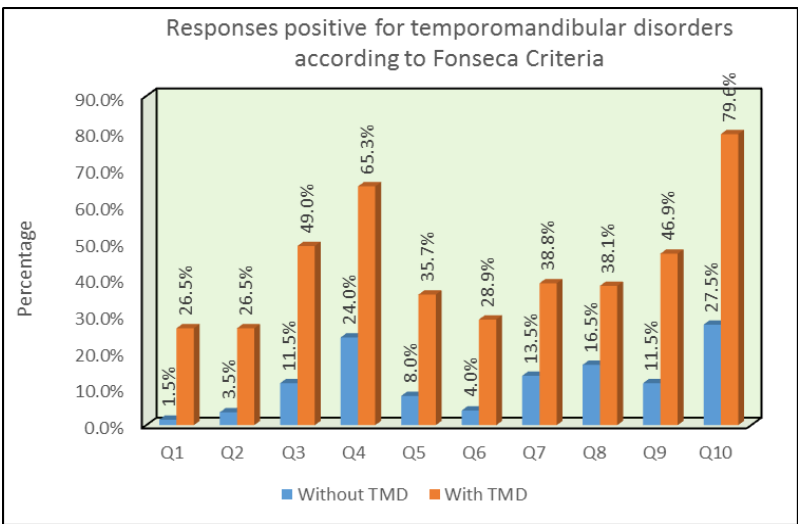
Figure 2: Responses positive for temporomandibular disorders according to Fonseca